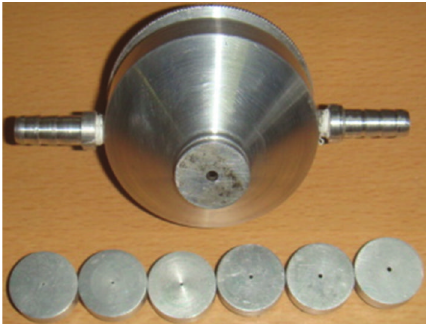
Figure 4: The assist gas nozzle and the seven di ff erent tips.